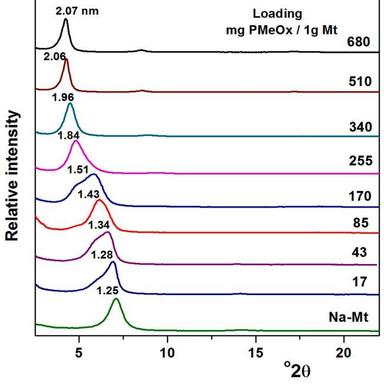
XRD patterns of PMeOx-Mt prepared with different initial amounts of PMeOx, indicated in the figure.